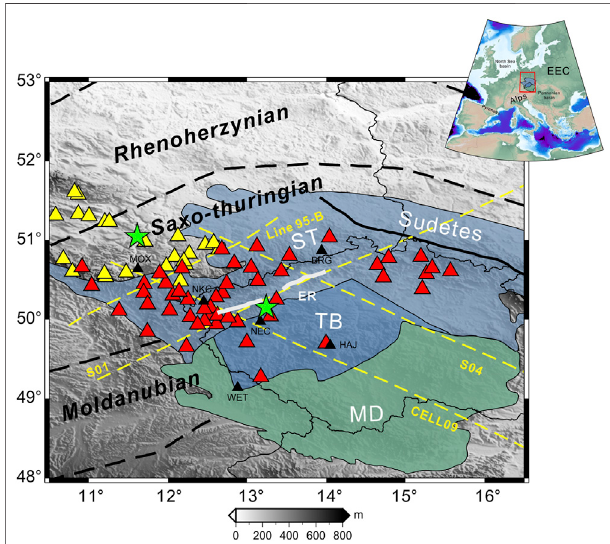
FIGURE1| Studyareaanddistributionofstations. Asimpli fi edoverview of the northwestern Bohemian Massif and adjacent areas (modi fi ed after Knapmeyer-Endrun et al. (2014) showing the major tectonic units and seismic stations (yellow and red triangles) used in this study. Major tectonic units and zones of the Bohemian Massif: ST, Saxo-Thuringian zone; TB, Teplá- Barrandian zone; MD, Moldanubian zone; ER, Eger Rift. EEC, Eastern European Craton. Black triangles denote the stations MOX, NKC, WET, and BRG used in Wilde-Piórko et al. (2005) and the stations NEC and HAJ used in Kolínský et al. (2011). Yellow and red triangles denote the seismic stations of arrays “ TH ” and “ ZV ” , respectively; and green pentagrams denote the center positions of the two arrays. The yellow dashed lines denote pro fi le 95-B of the GRANU95 project, pro fi le CEL09, pro fi le S01 and pro fi le S04.